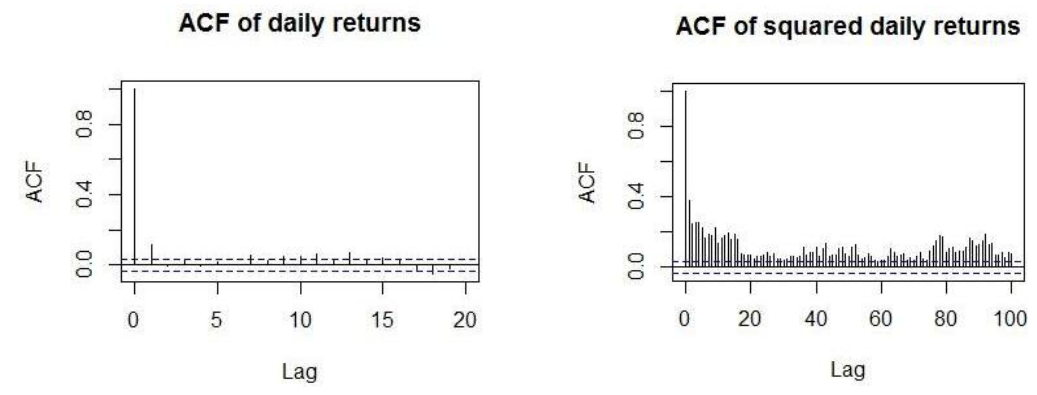
Figure 6. The autocorrelation function of daily and squared daily